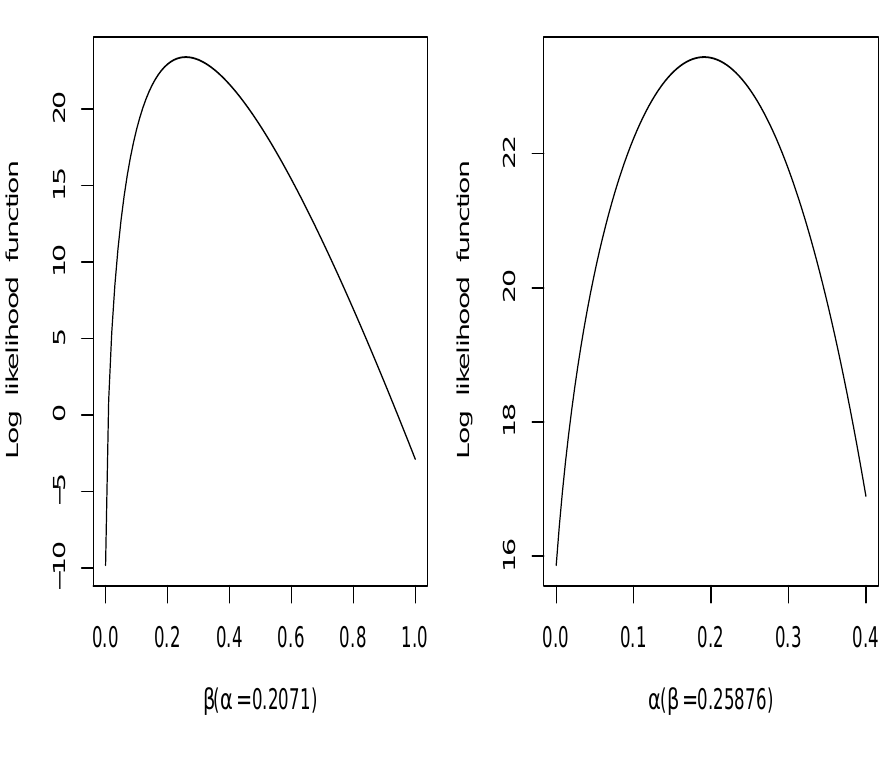
Figure 2 – Log likelihood function based on scheme 1.